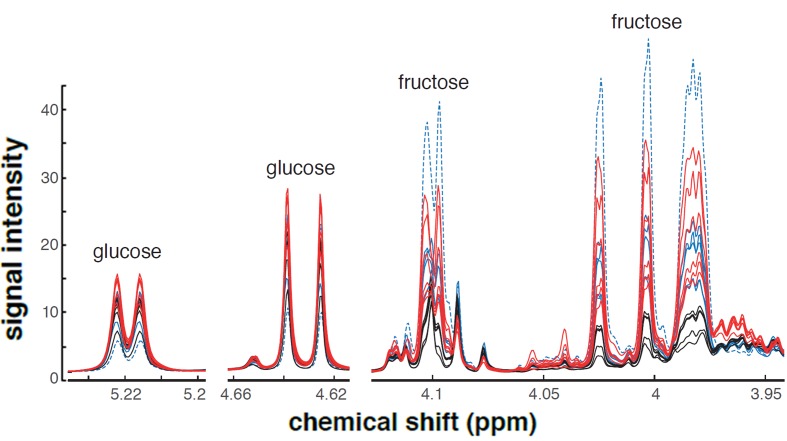
NMR-spectra of glucose and fructose.The depicted spectra are specific to either glucose or fructose. Signals with contributions from both sugars are excluded. The individual spectra indicate increased levels of both monosaccharides in response to muscle-specific Nep4A overexpression (mef2-Gal4 x UAS-Nep4A; red), relative to control animals (mef2-Gal4 x w1118; black). The effects of nep4 knockdown (mef2-Gal4 x UAS nep4-RNAi) are depicted in blue. One nep4 knockdown sample was distinctly different from the other five. The outlier is marked by a dotted line and was excluded from further analysis.